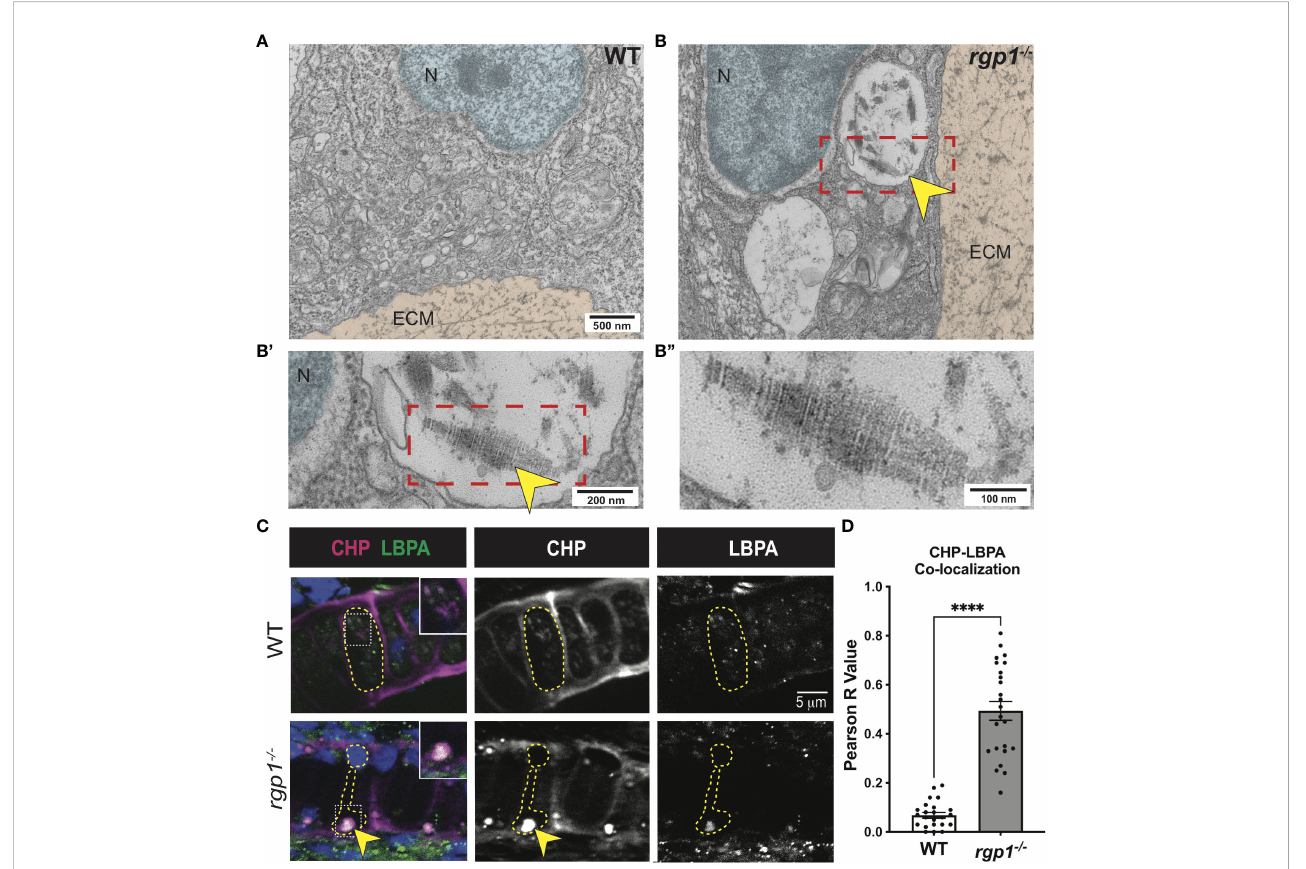
FIGURE 4 Collagen II accumulations in rgp1 -/- chondrocytes localize to endolysosomes (A) TEM images of 3 dpf WT craniofacial chondrocytes. (B) TEM images of 3 dpf rgp1 -/- craniofacial chondrocytes showing vacuolar structures (yellow arrowhead) (B ’ ) Enlarged image of boxed area showing striated ultrastructure of intracellular collagen fi brils (yellow arrowhead). (B ” ) Further enlargement of boxed area. (C) Representative images of chondrocytes in WT and rgp1 -/- cartilage (CHP, magenta; LBPA, green). Insets are enlargements of white dashed boxes, and an intracellular accumulation is labeled with a yellow arrowhead. (D) Quanti fi cation of the Pearson R value for co-localization in individual chondrocytes. Signi fi cance is presented by